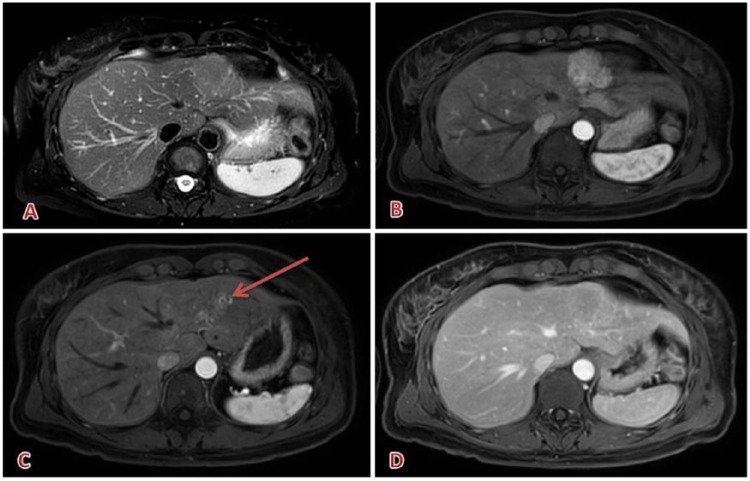
Typical hepatic focal nodular hyperplasia: (A) iso-hyperintense on T2, (B) early and strong washin in arterial phase; (D) rapid washout (portal phase); (C) serpiginous arterial vessels inside the lesion (arrow). Contrast agent: gadobutrol, 7 mL. Courtesy of Professor De Cobelli, Radiology Department, San Raffaele Scientific Institute, Milan.